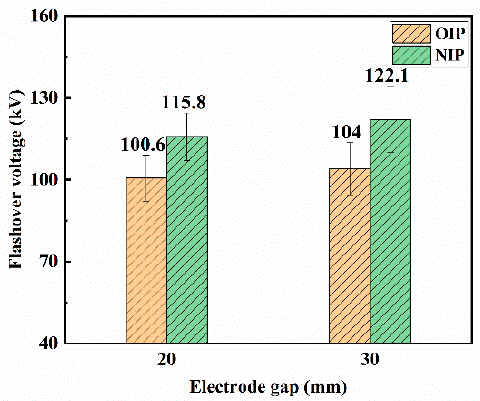
Nanomaterials 2019 , 9 , x FOR PEER REVIEW Figure 7. Creeping flashover voltages of OIP and NIP under negative lightning impulse voltages.